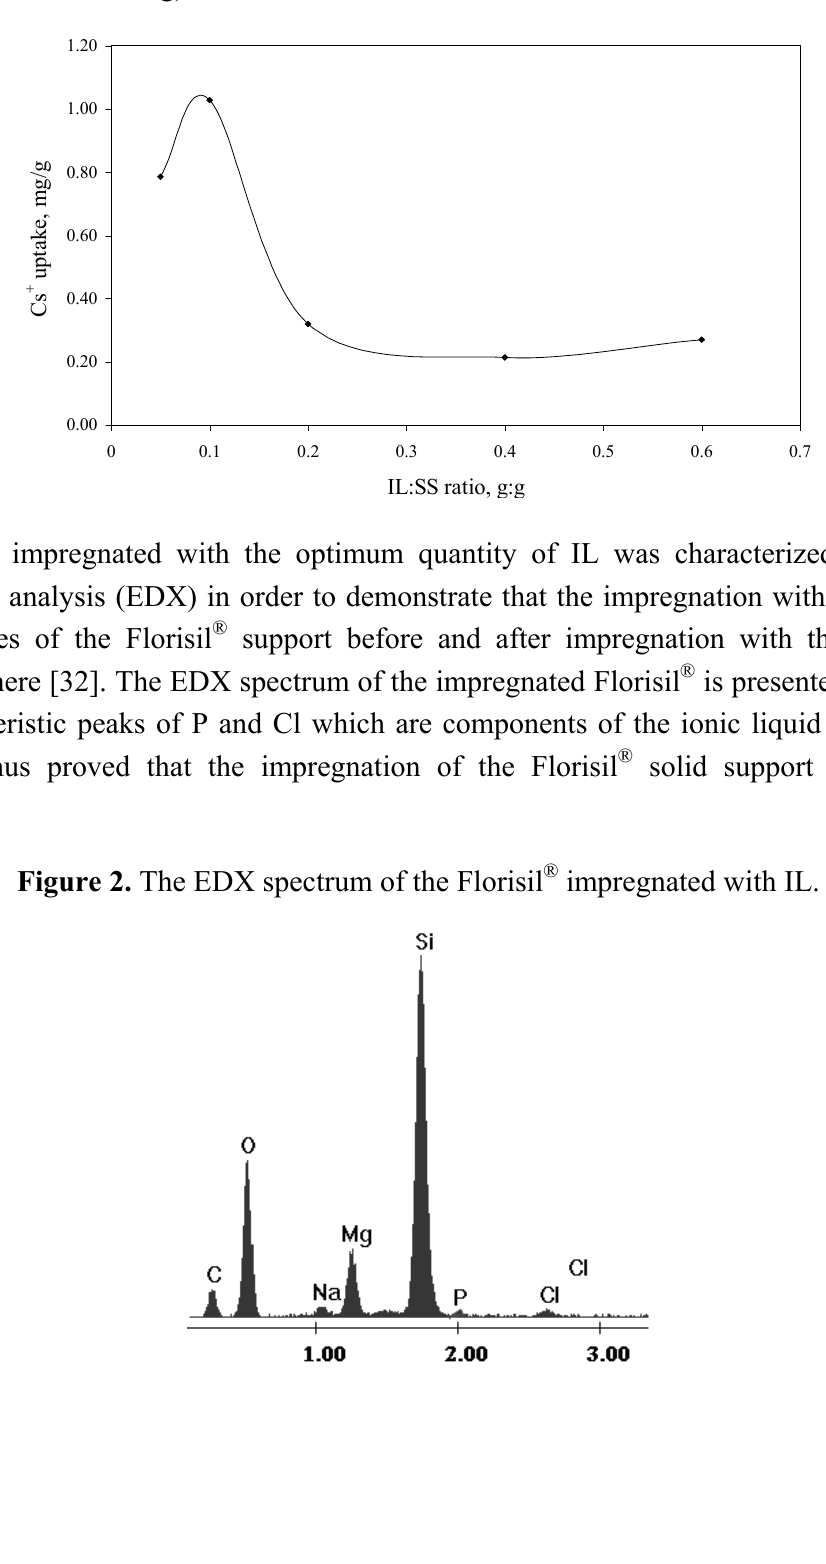
= 10 mg/L, V = 25 mL, i